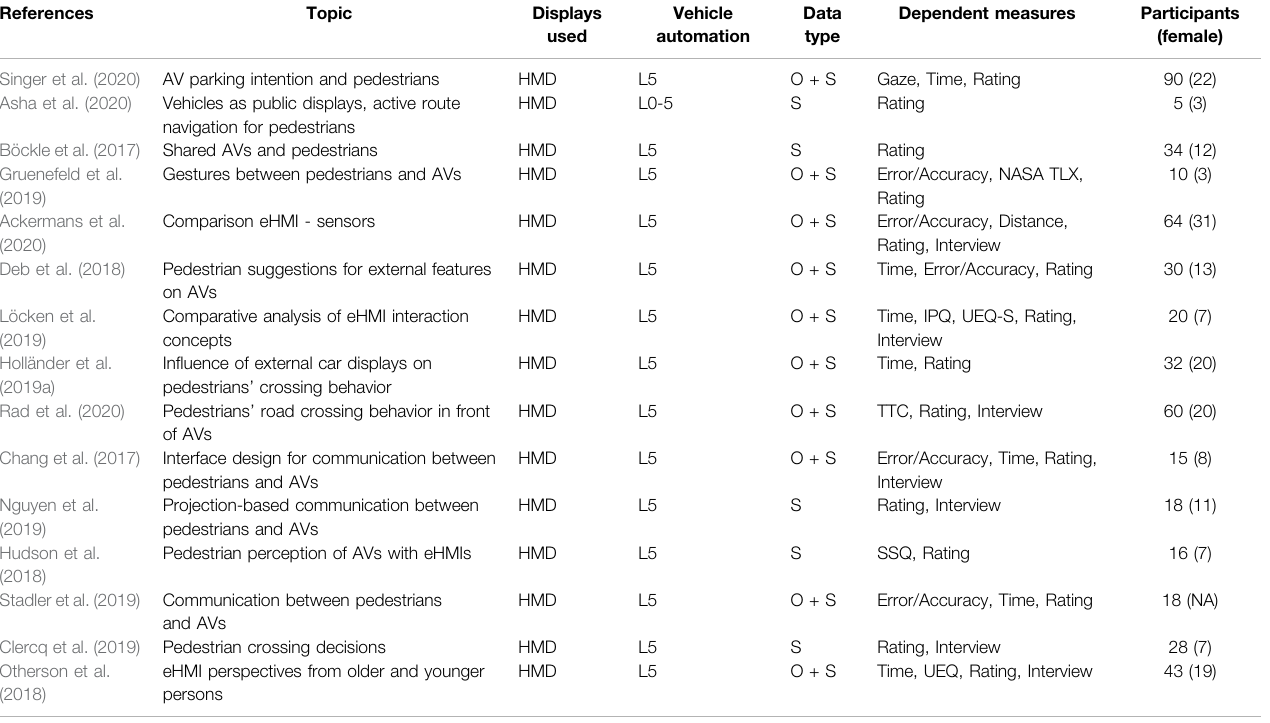
TABLE 12 | Summary of user studies in External HMI application area.